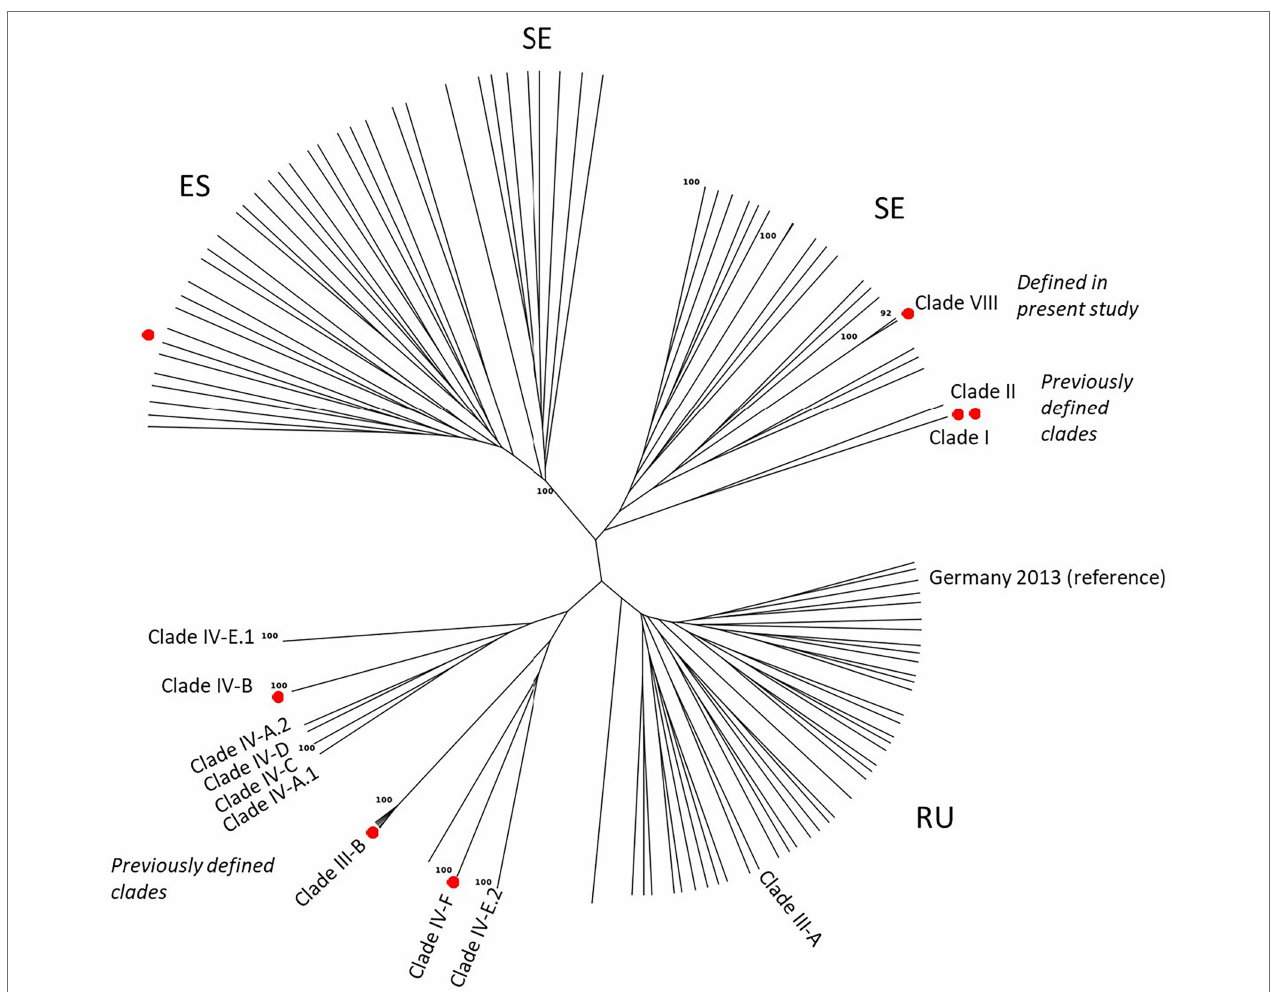
FIGURE 5 | Unrooted Neighbor Joining tree (clone-corrected data) using Bruvo’s distance showing the genetic relationship of European stem rust isolates (2016– 2021) and additional reference isolates representing previously defined genetic groups (Clades) detected in Europe and elsewhere. National letter codes are indicative: ES (Spain), SE (Sweden), RU (Russia). Red dots represent isolates used for assessment of host